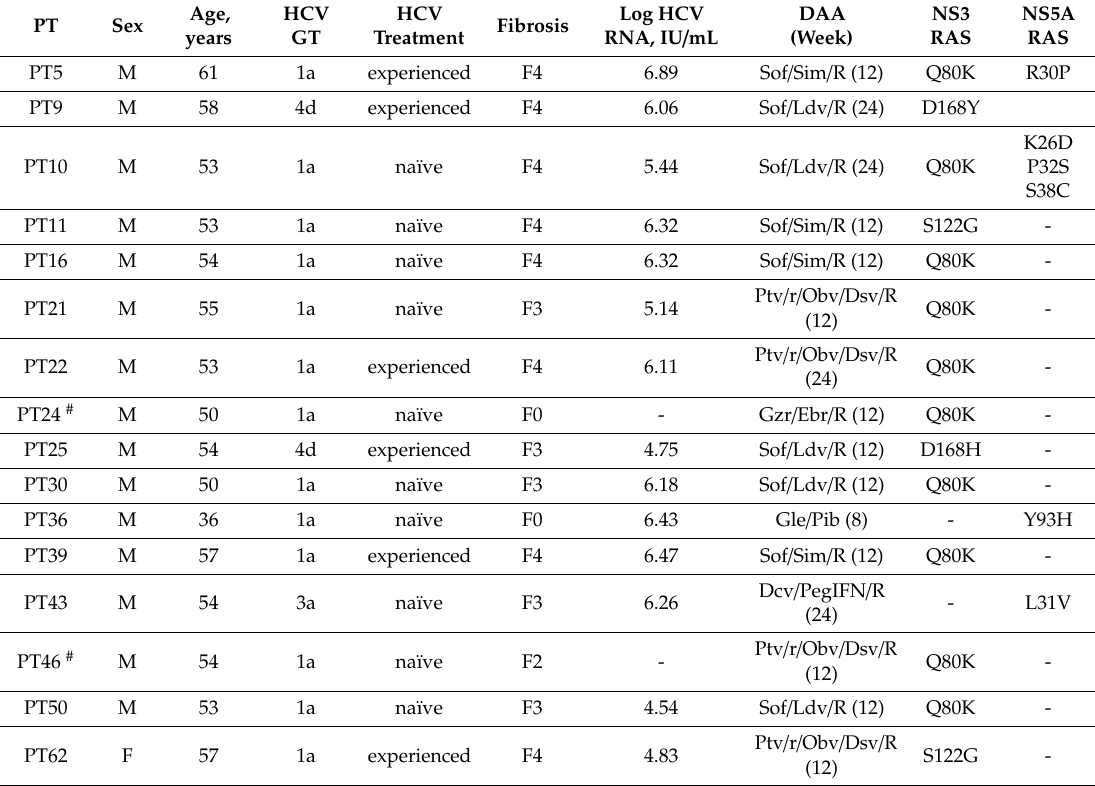
Table 2. Characteristics of 16 HIV-1 / HCV coinfected patients with SVR and baseline direct-acting antivirals (DAA) resistance.